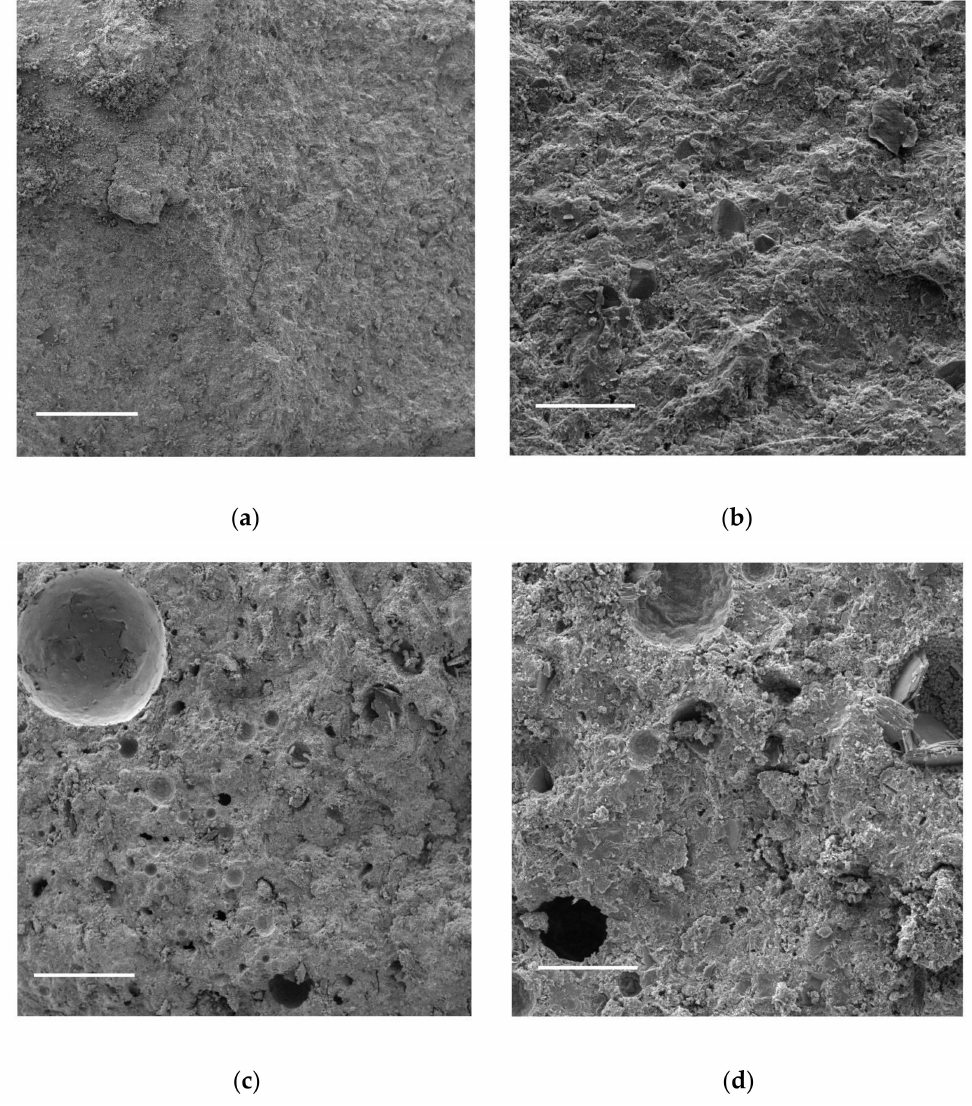
Figure 8. SEM images of the pastes at 7 days of hydration. REF: ( a ) [ × 100; scale = 500 µ m]; ( b ) [ × 500; scale = 100 µ m]. 5% T: ( c ) [ × 100; scale = 500 µ m]; ( d ) [ × 500; scale = 100 µ